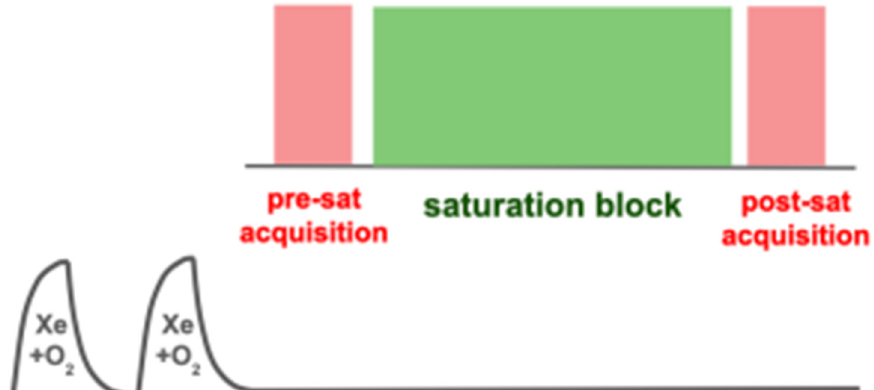
Figure 22. A general scheme for XTC measurements consists of one or more breaths during which HXe gas is introduced, and two MRI acquisitions separated by a period of ‘saturation’ (dissolved phase signal destruction). The extent of that destruction and its communication to the gas phase through diffusion is quantified using the difference between pre-sat and post-sat measurements.